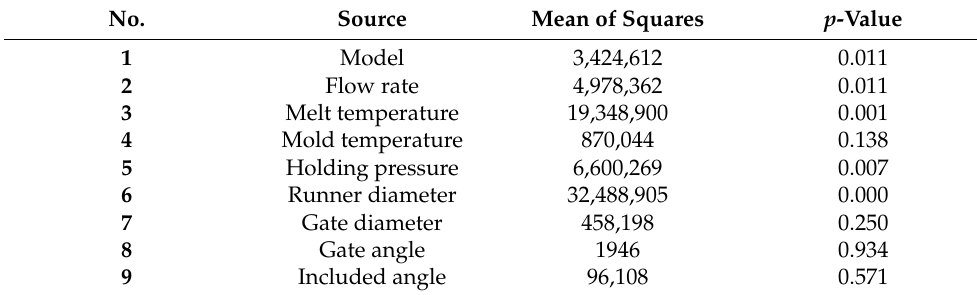
Table 4. ANOVA results of the screening step.